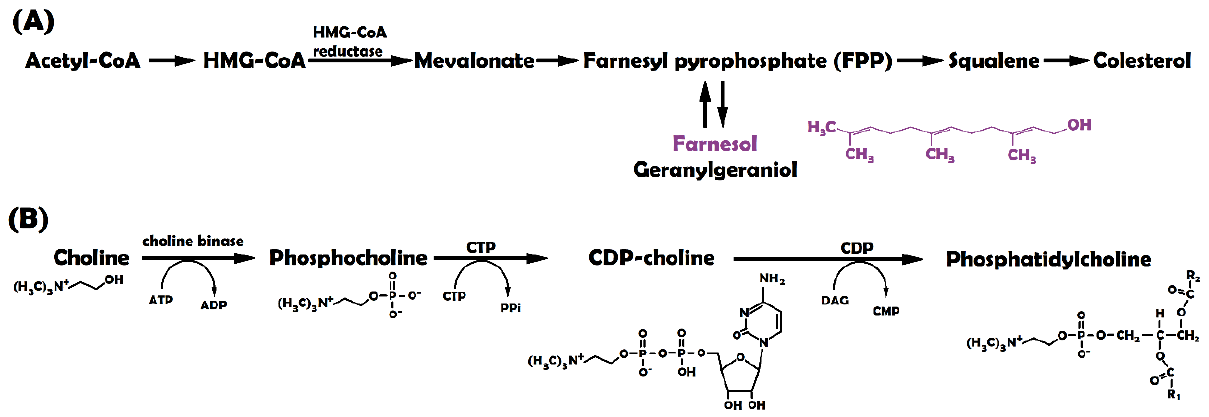
Figure 1. ( A ) Farnesol formation in mevalonate pathway [5]; ( B ) Phosphatidylcholine formation.